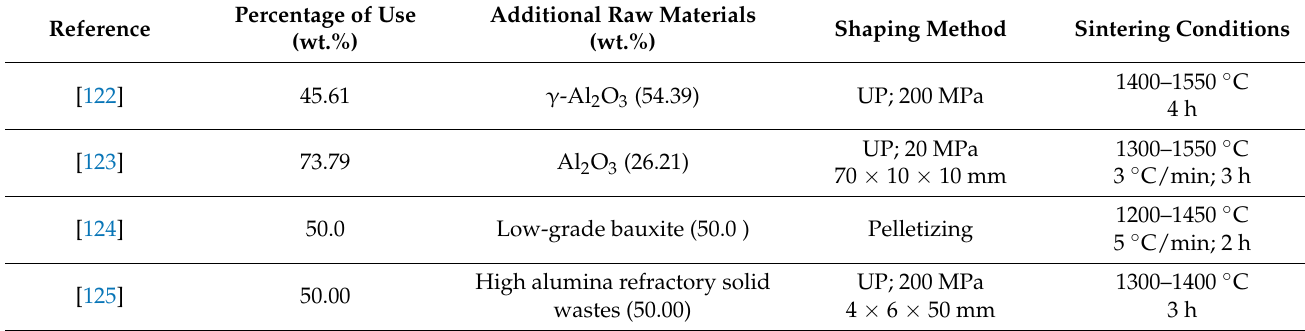
Table 13. Experimental conditions used in the development of mullite-based materials from coal gangue.